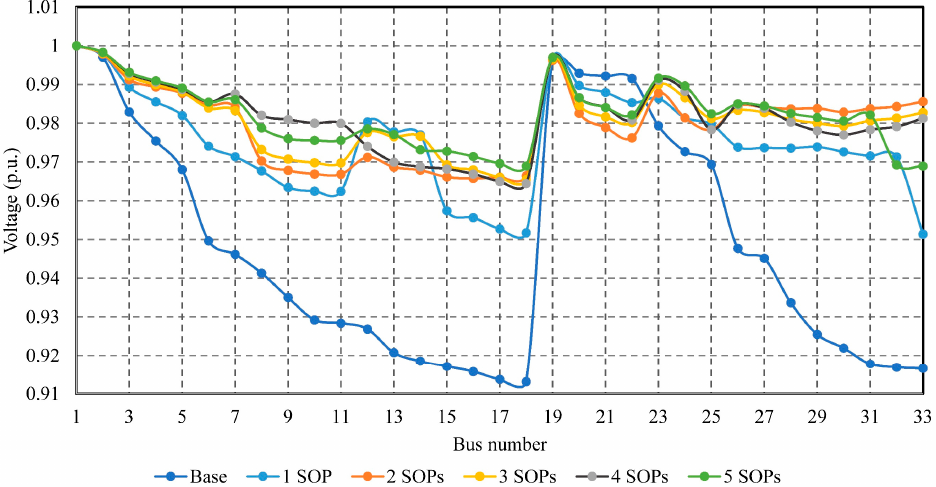
Figure 6. Improvement of the voltage profile at normal loading condition with SOPs power loss considered: scenario 9.